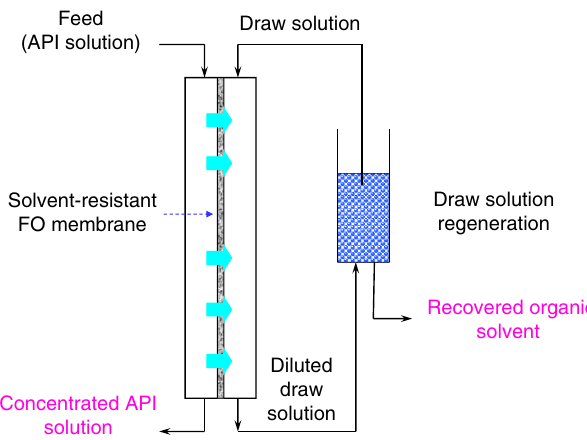
Fig. 1 Schematic diagram of a forward osmosis process for organic solvent recovery. At the membrane compartment, the solvent from the feed solution transports through the membrane to the draw solution while the solutes are rejected. As a result, the feed solution is concentrated while the draw solution is diluted. Subsequently, the diluted draw solution can be regenerated by many means, such as direct fi ltration, distillation